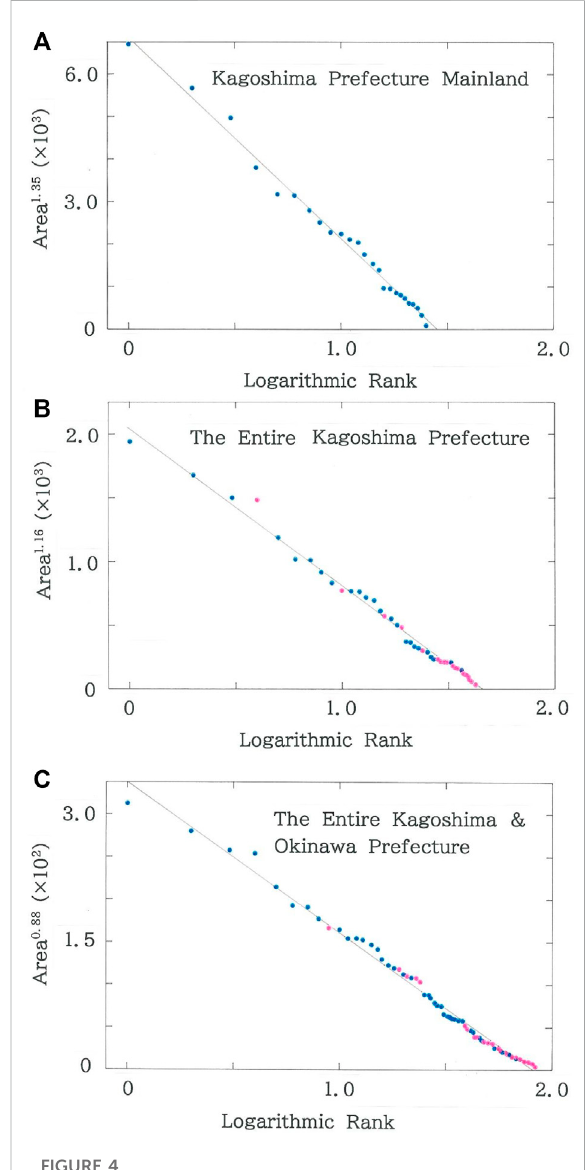
FIGURE 4 (A) Dependence of the areas (km 2 ) of municipalities in the mainland of Kagoshima Prefecture on the logarithmic rank. The brown declining line indicates the optimized fi t (| r | = 0.9951 with d = 1.277 for q = 1.35 and n = 25; a = 6.86×10 3 , b = 4.72×10 3 ). (B) Dependence of the areas (km 2 ) of municipalities in the entire Kagoshima Prefecture on the logarithmic rank. The brown line indicates the optimized fi t (| r | = 0.9955 with d = 1.055 for q = 1.16 and n = 43; a = 2.05×10 3 , b = 1.24×10 3 ). Data of municipalities on the territorial islands are highlighted with pink dots. (C) Dependence of the areas (km 2 ) of municipalities in the entire Kagoshima and Okinawa Prefecture on the logarithmic rank. The brown line indicates the optimized fi t (| r | = 0.9955 with d = 0.557 for q = 0.88 and n = 84; a = 3.37×10 2 , b = 1.77×10 2 ). Data of municipalities in Okinawa Prefecture are highlighted with pink